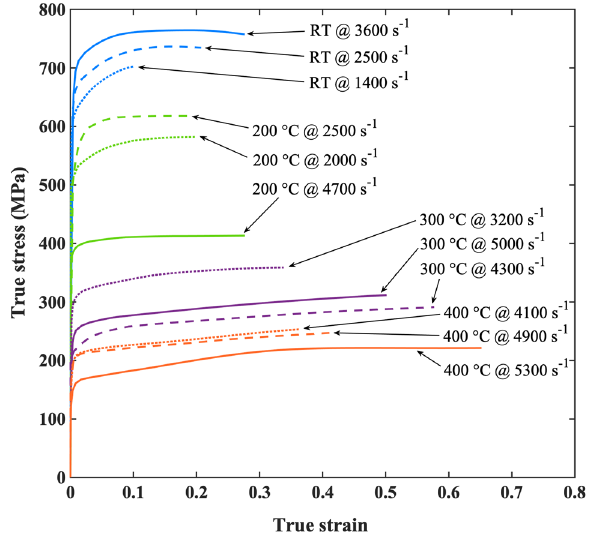
Fig. 4 True stress–strain curves of AA7075-T651 compressed with high strain rates at different temperatures